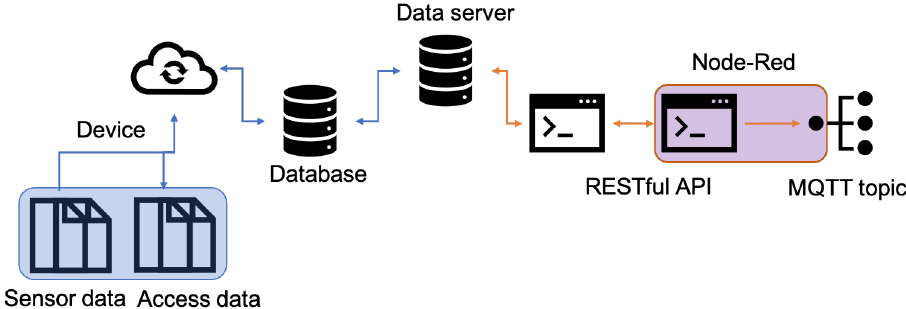
Figure 1. Backbone diagram of the monitoring system.